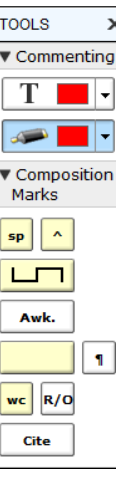
Figure 3. Tools palette on the PeerMark platform.